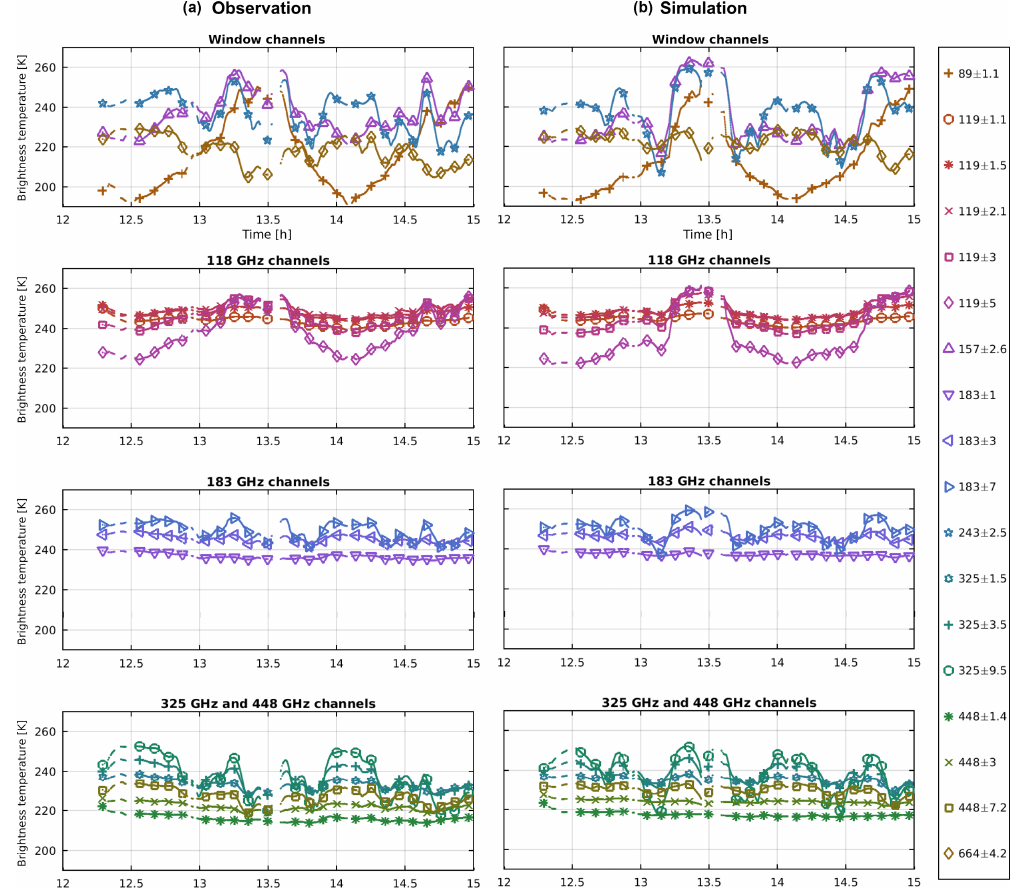
Figure 7. (a) Observed brightness temperature time series of flight B897. (b) Simulated brightness temperature time series of flight B897. The markers are shown only for every 100th